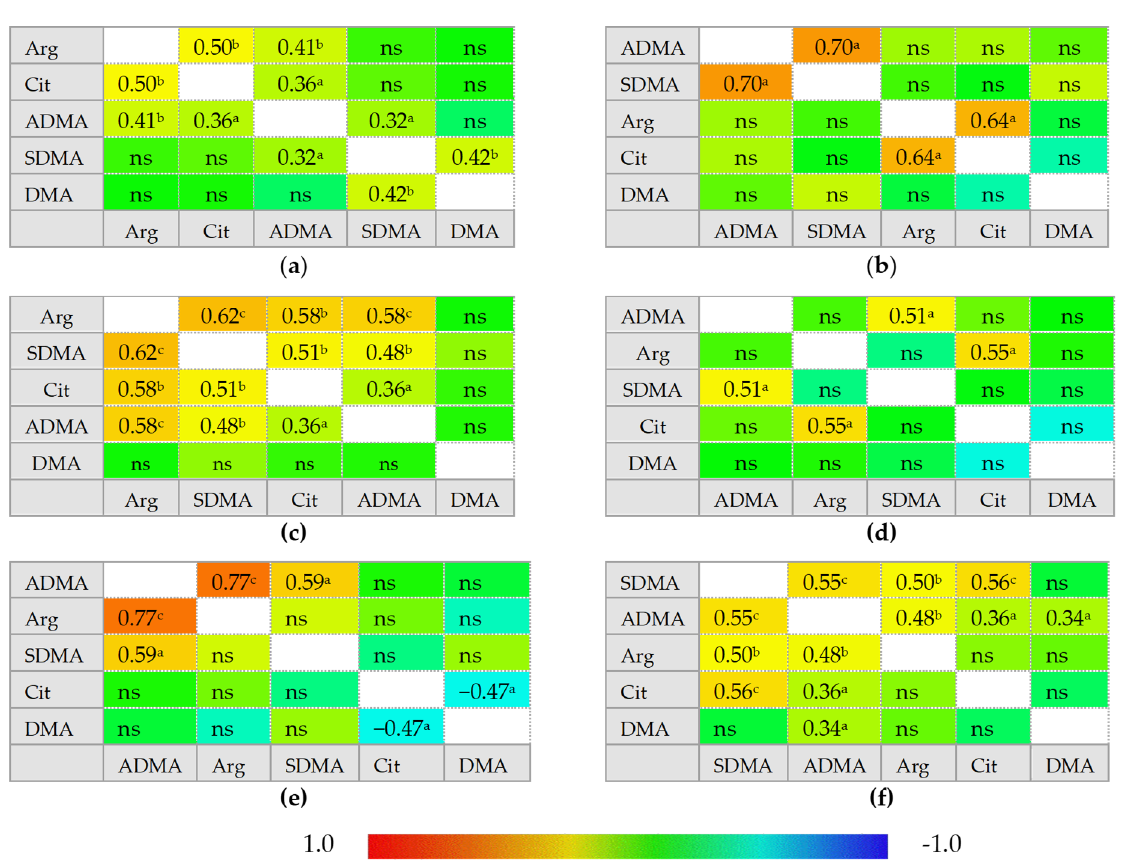
Figure 2. Correlogram for L-arginine / NO pathway metabolites: ( a ) in patients with active Crohn’s disease; ( b ) in patients with inactive Crohn’s disease; ( c) in patients with active ulcerative colitis; ( d ) in patients with inactive ulcerative colitis; ( e ) in patients with irritable bowel syndrome; ( f ) in healthy controls. Results presented as correlation coefficients r and analyzed on log-transformed data using Pearson’s correlation test; a p < 0.05; b p < 0.01; c p < 0.001; d p < 0.0001; ns, non-significant; Arg, arginine; Cit, citrulline; ADMA, asymmetric dimethylarginine; SDMA, symmetric dimethylarginine; DMA, dimethylarginine.